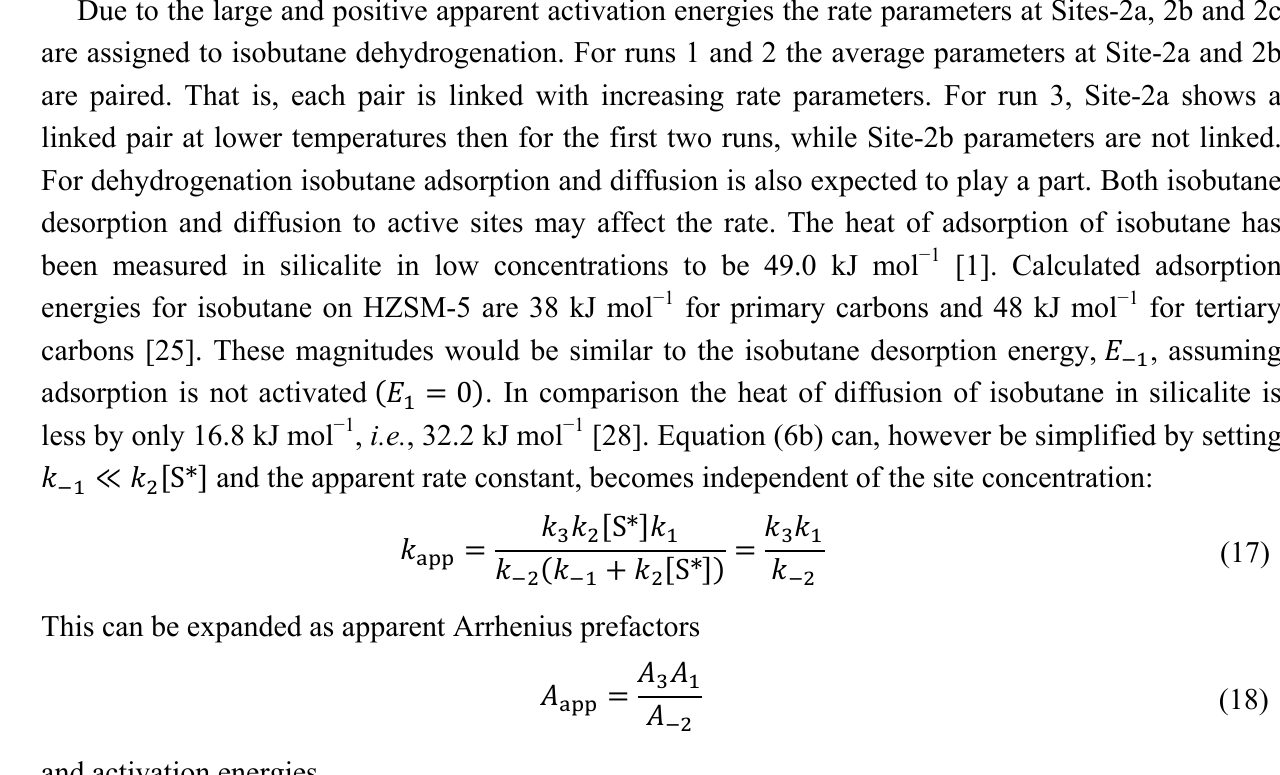
Table 4 lists isobutene average desorption activation energies, (cid:1831) calculated using Equation (16) (cid:2874) and with (cid:1831) (cid:3404) 56.5 kJ mol − 1 and (cid:1831) (cid:3404) 0 , i.e. , non-activated isobutane adsorption. The overall (cid:2879)(cid:2873) (cid:2869) average of all energies is 77 ± 12 kJ mol − 1 . The mean value is within 4.2 kJ mol − 1 of the heat